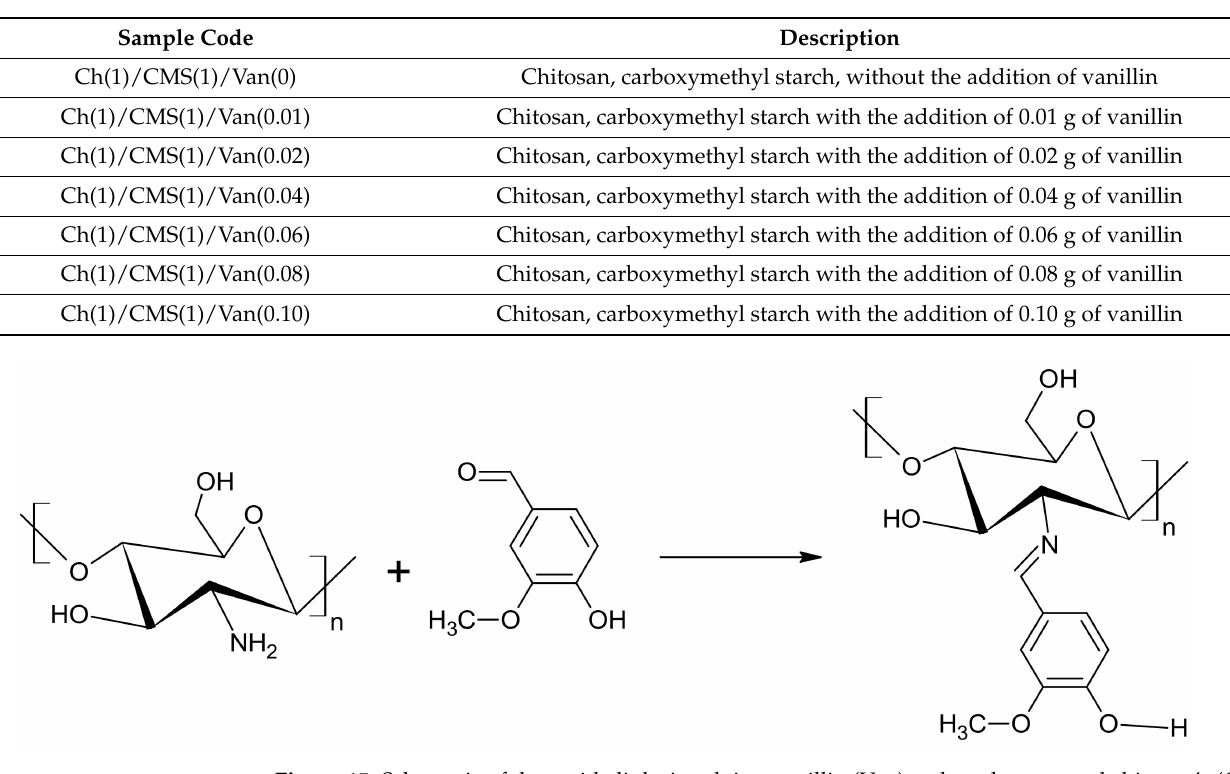
Figure 15. Schematic of the amide links involving vanillin (Van) carbonyl group and chitosan’s (Ch) amine